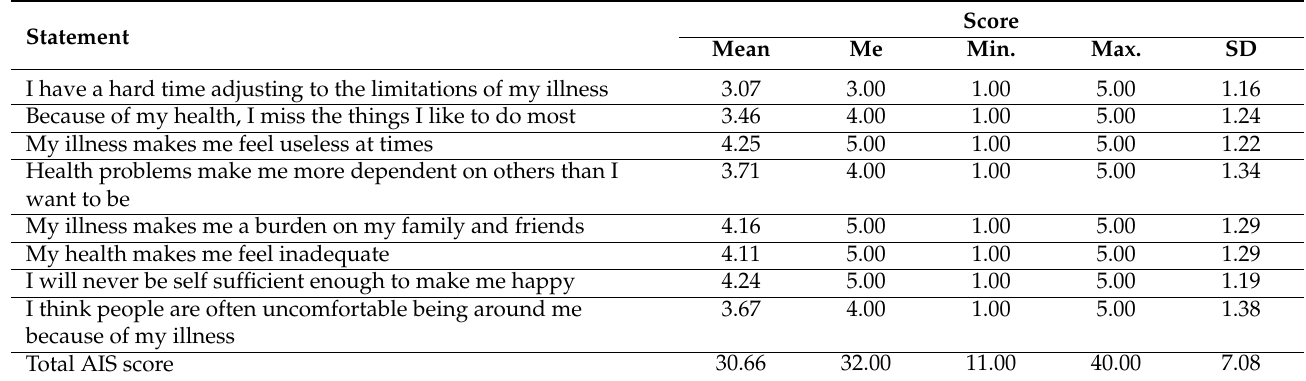
Table 5. Average acceptance of illness scores in the AIS scale within the group of diabetic women